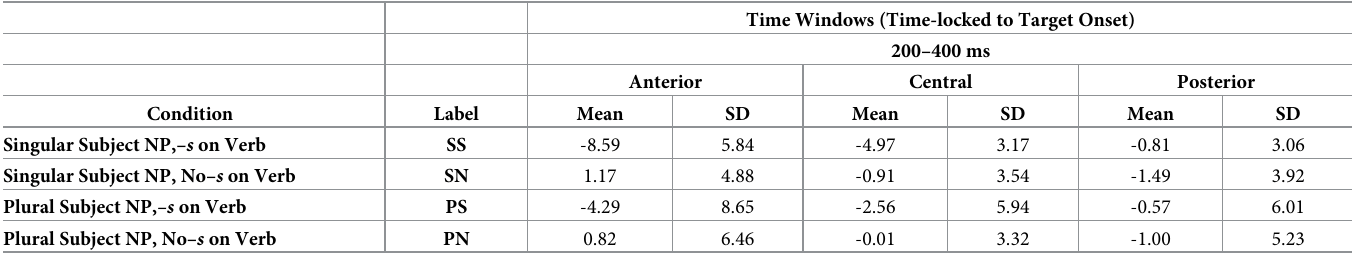
Table 5. Mean ERP amplitudes ( μ V) and their SDs for the four experimental conditions in the 200–400 ms time window.